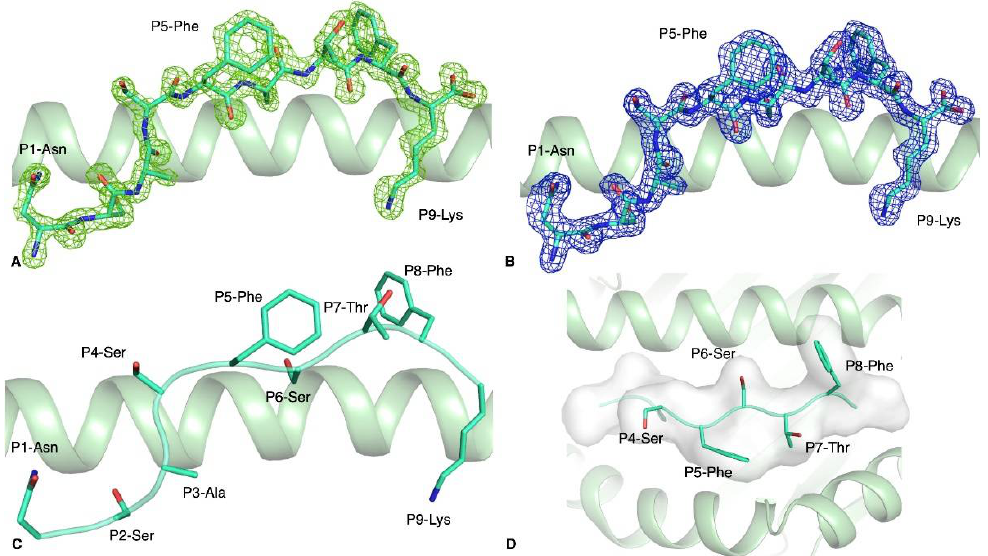
Figure 2. Structure of the HLA-A*11:01-S 370–378 complex. Electron density map of ( A ) Fo-Fc at 3σ (green) and ( B ) 2Fo-Fc at 1σ (blue) around the S 370–378 peptide (green stick) presented by the HLA-A*11:01 molecule (green cartoon). ( C ) Side view of the S 370–378 peptide (green stick) showing the solvent exposed and anchor residues. ( D ) Top view of the antigen-binding cleft of HLA-A*11:01 (green cartoon) with the S 370–378 peptide represented as green stick and cartoon as well as a white surface to show that the surface is available for potential contact with T cells.